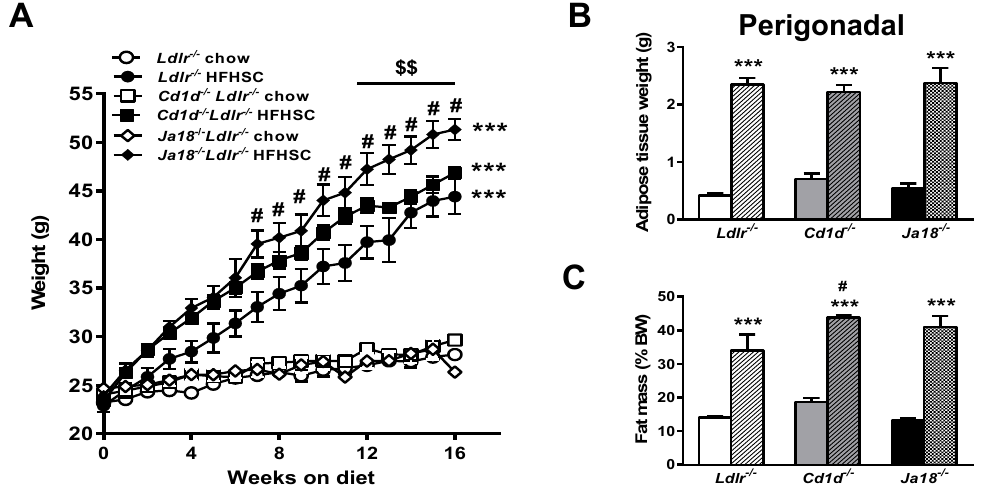
Figure 1. Invariant natural killer T (iNKT) cell deficient Ja18 − / − Ldlr − / − mice exhibit increased weight gain. ( A ) Significantly increased weight gain in Ja18 − / − Ldlr − / − mice fed high fat, high sucrose cholesterol enriched (HFHSC) diet for 16 weeks; ( B ) Perigonadal adipose tissue weights; ( C ) Body composition analysis revealed increased generalized fat distribution in all groups of obese mice. Data represent means ± standard error of the mean (SEM), n = 10 mice per group. *** p < 0.001 vs. lean mice of corresponding group, # p < 0.01 vs. HFHSC-fed Ldlr − / − mice, $$ p < 0.001 vs. HFHSC-fed Cd1d − / − Ldlr − / − mice. Open symbols and solid bars—chow-fed animals; closed symbols and hatched bars—HFHSC-fed animals. BW: body weight.